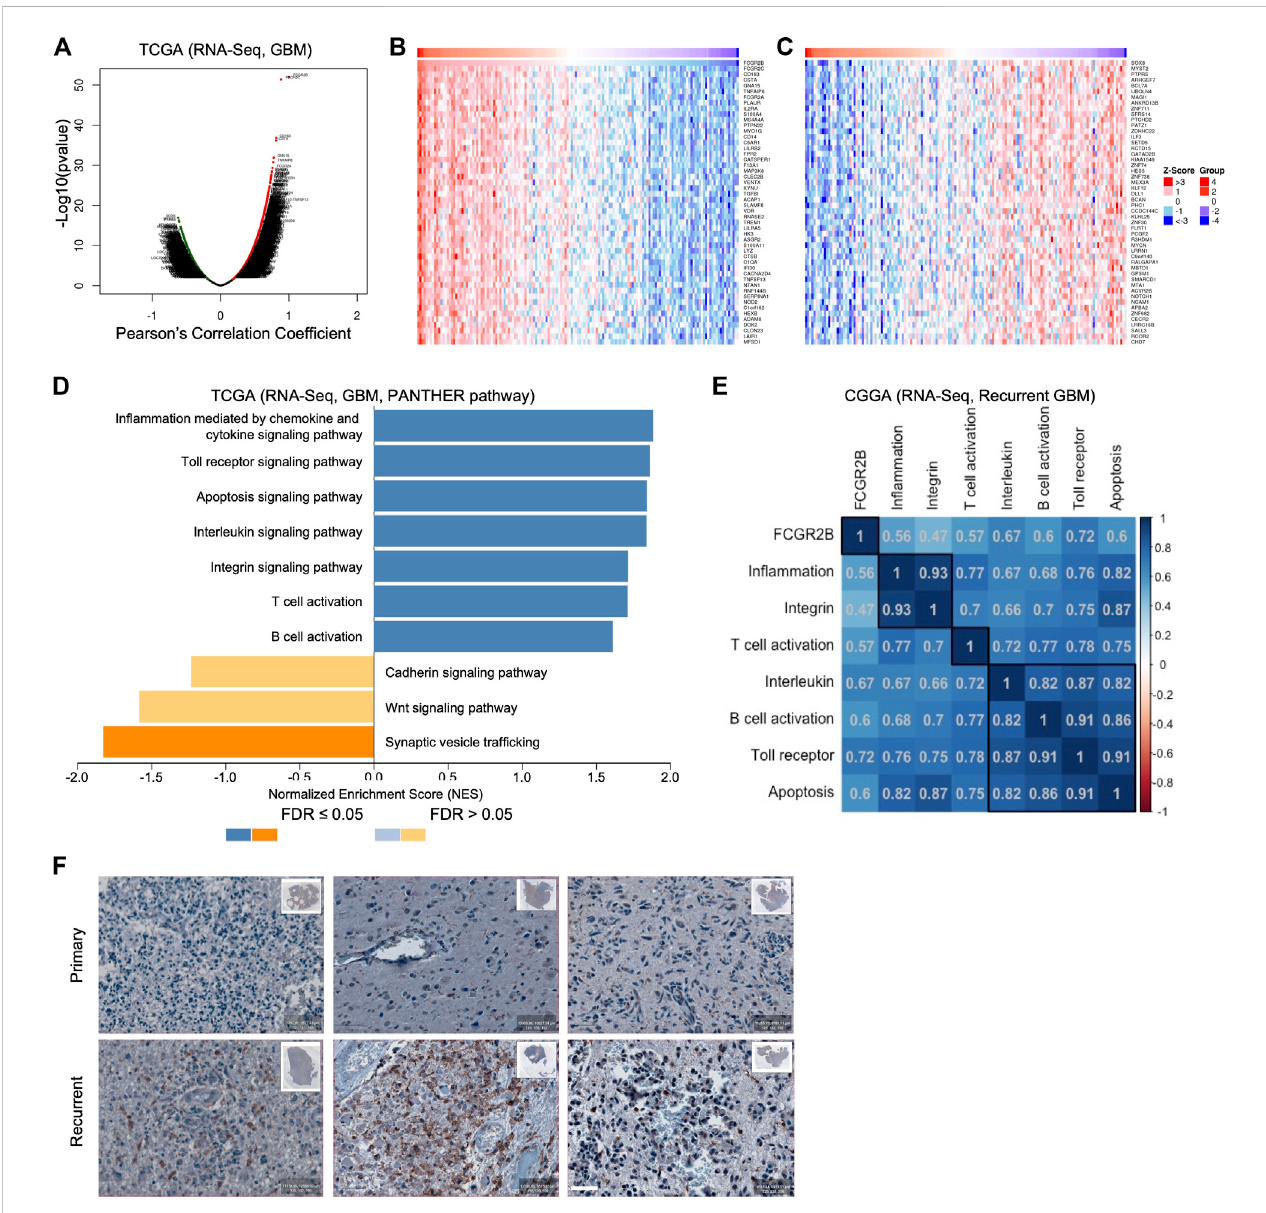
FIGURE 6 Fc γ RIIb regulates immune-associated signaling pathways in recurrent GBM. (A) Volcanoplotshowing FCGR2B -associated genes from theTCGAcohort ranked by their Pearson ’ s correlation coef fi cient R-value and p -value. Red dots, positively correlated signi fi cant genes, R > 0, p < 0.05; black dots, no relationshipgenes, p > 0.05;greendots,negativelycorrelatedsigni fi cantgenes,R < 0, p < 0.05. (B , C) Theheatmapshowsthetop50genesthatwerepositively (B) and negatively (C) correlated with FCGR2B expression in the TCGA cohort. (D) Bar charts showing the signaling pathways that were signi fi cantly enriched in the FCGR2B high group (blue bar) and in the FCGR2B low group (orange) from the TCGA cohort using GSEA with the Protein ANalysis THrough Evolutionary Relationships (PANTHER) pathway signatures. (E) The correlation matrix showing the Pearson ’ s correlation coef fi cient between mRNA expression of FCGR2B and the enrichment score of immune-associated signaling pathways calculated through ssGSEA using the CGGA recurrent GBM cohort. (F) Representative images of immunohistochemistry (IHC) showing Fc γ RIIb-positive cell populations in primary and paired recurrent specimens from three GBM patients. Scale bar = 50